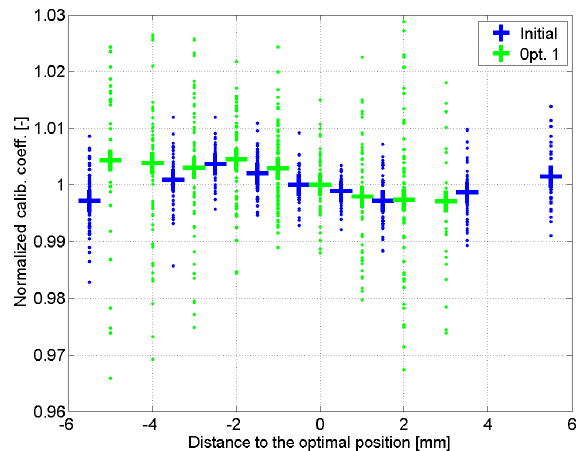
Figure 6. Normalized calibration coefficient as a function of lateral spot displacement (test no. 2 in Fig. 4) for three optical configura- tions of the receiving module (similar to Fig. 5). The vertical dashed lines show the limits of lateral displacements for which less than half of the spot actually enter the fiber.